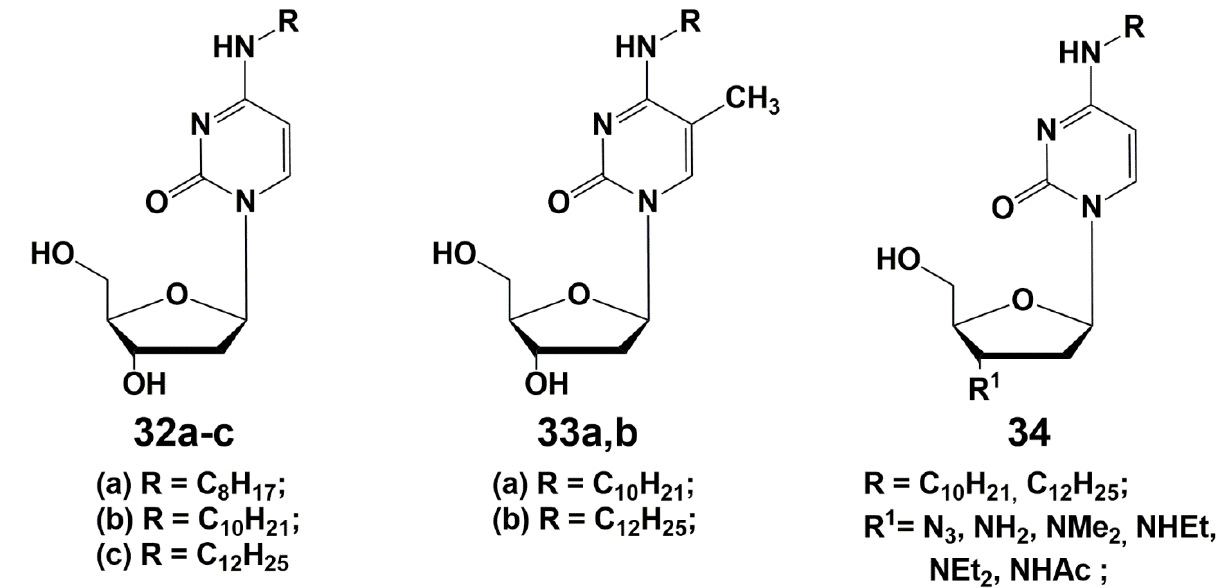
Figure 9. N4-Alkyl derivatives of 2 ′ -deoxycytidine and 2 ′ ,3 ′ -dideoxy-3 ′ -modified cytidine. N4-alkyl-2 ′ -deoxy-5-methylcytidines ( 34 ) with additional modifications of the car-